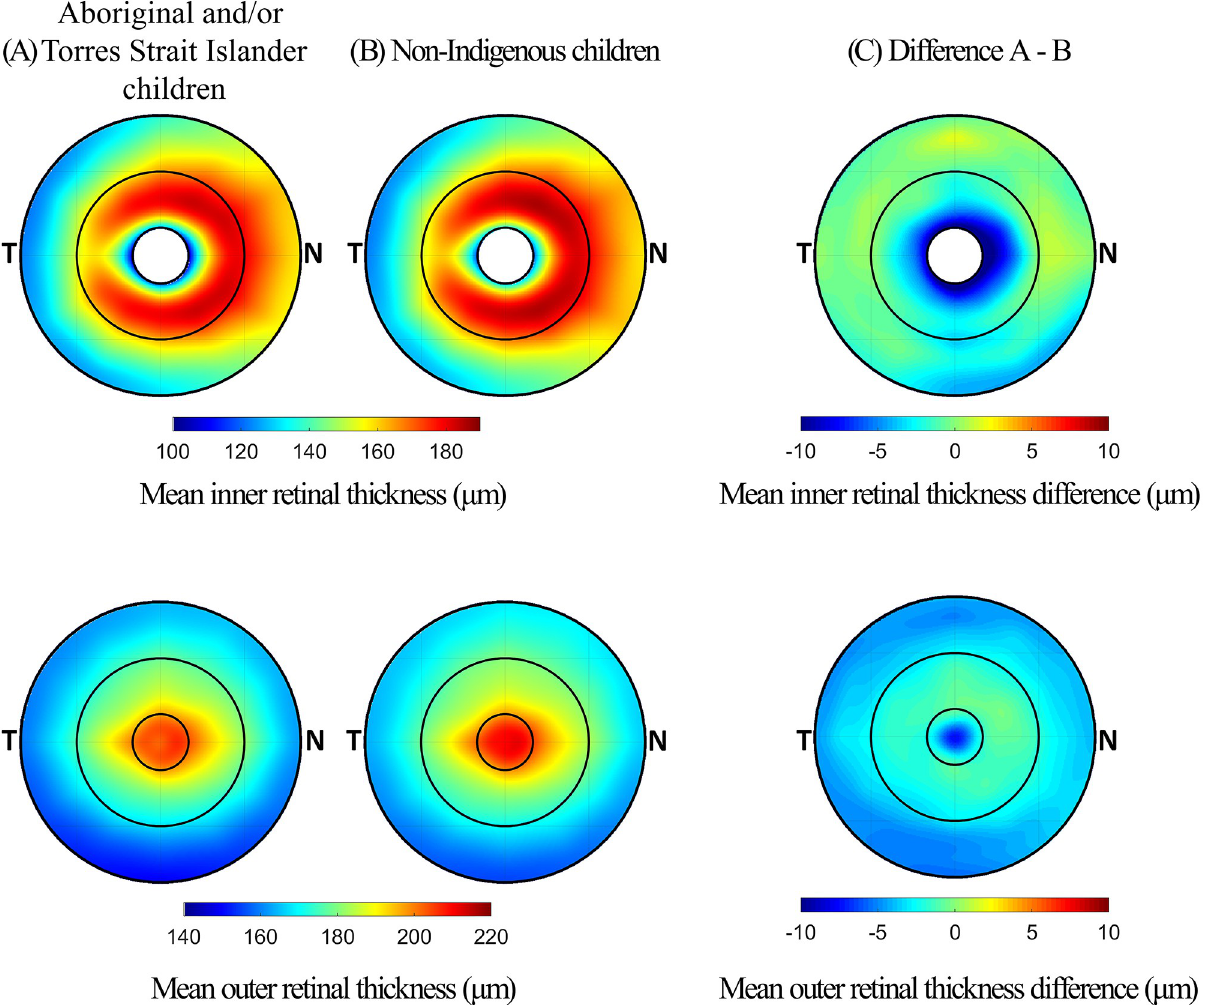
Fig 5. Mean inner retinal layer thickness (top) and outer retinal layer thickness (bottom) for (A) Aboriginal and/or Torres Strait Islander children and (B) non-Indigenous children, and (C) the differences between the two